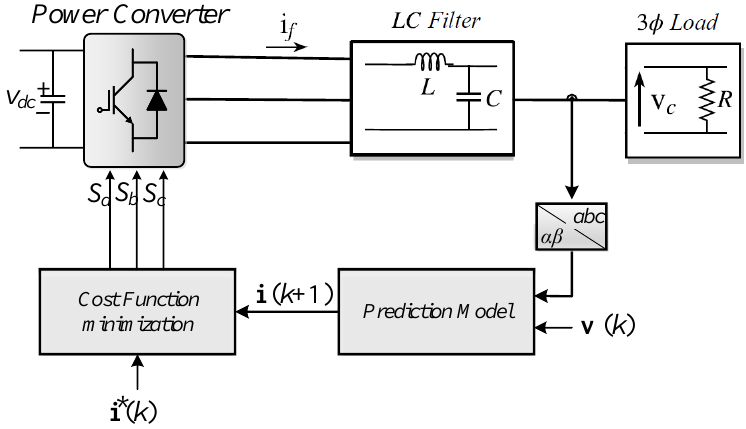
Figure 1. Conventional model predictive control strategy for an